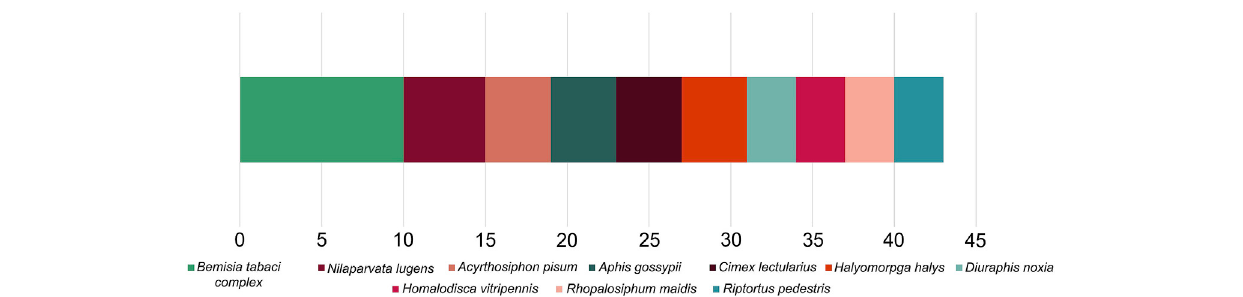
FIGURE 4 | The ten most sequenced species (or species complex) within the Hemiptera with the number of submissions for each shown, based on NCBI data.